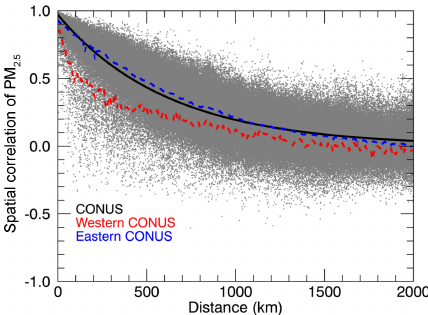
Figure 10. For 2008–2009 over the CONUS, scatter plot of dis- tance (km) between any two U.S. EPA stations and the correspond- ing spatial correlation of PM 2 . 5 concentration between each pair of stations. The black curve represents the exponential fit to the data for the entire CONUS, and the red and blue dashed lines represent 10km bin averages for the western and eastern CONUS, respec-